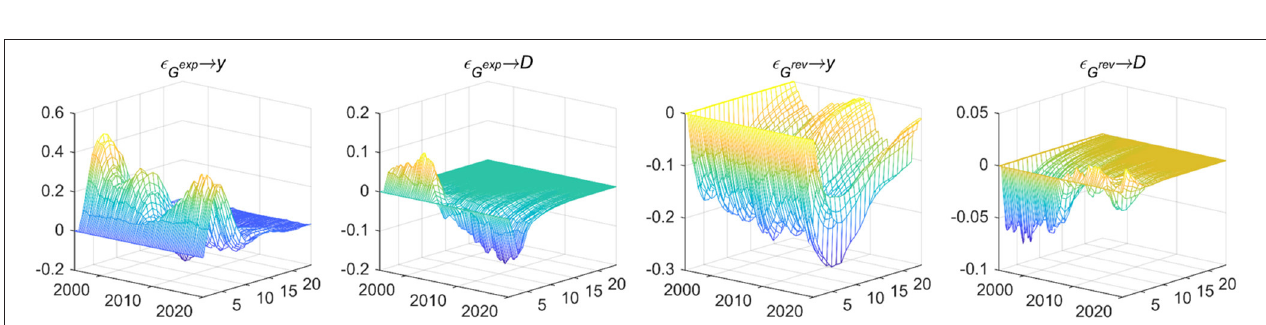
FIGURE 3 | The macroeconomic control effect of fiscal policy. Each subfigure with the title of “ X → Y ” demonstrates the response of variable Y to an orthogonalized positive shock of variable X . In other words, X is an impulse variable, and Y is a response variable. One period in the figure denotes one season.